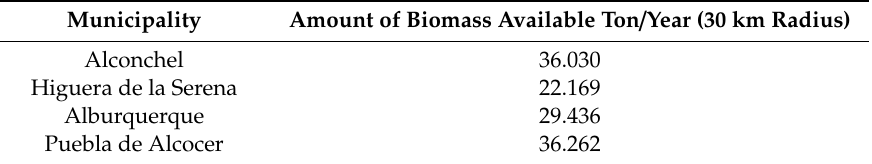
Table 6. Location of future storage centers forest biomass.